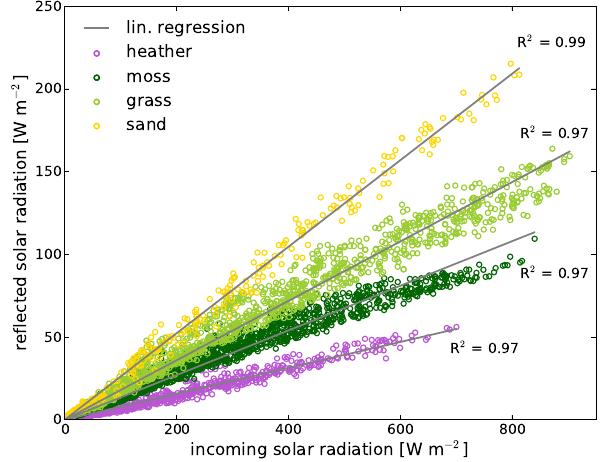
Figure 6. Linear regression between incoming and reflected solar